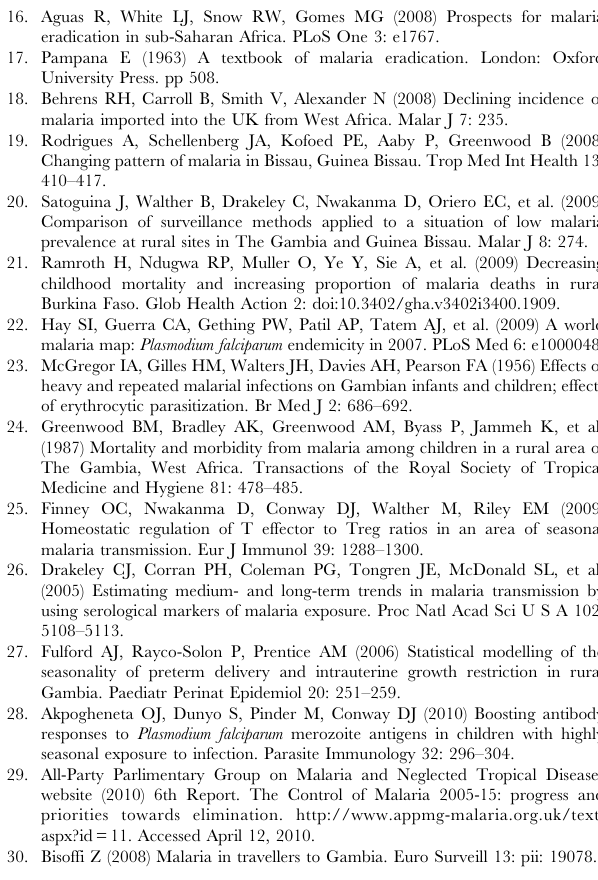
Figure S1 Seasonality and temporal trends between January 2003 and December 2009 in numbers of malaria positive slides at each of 10 health facilities. (A) Plots show number of malaria-